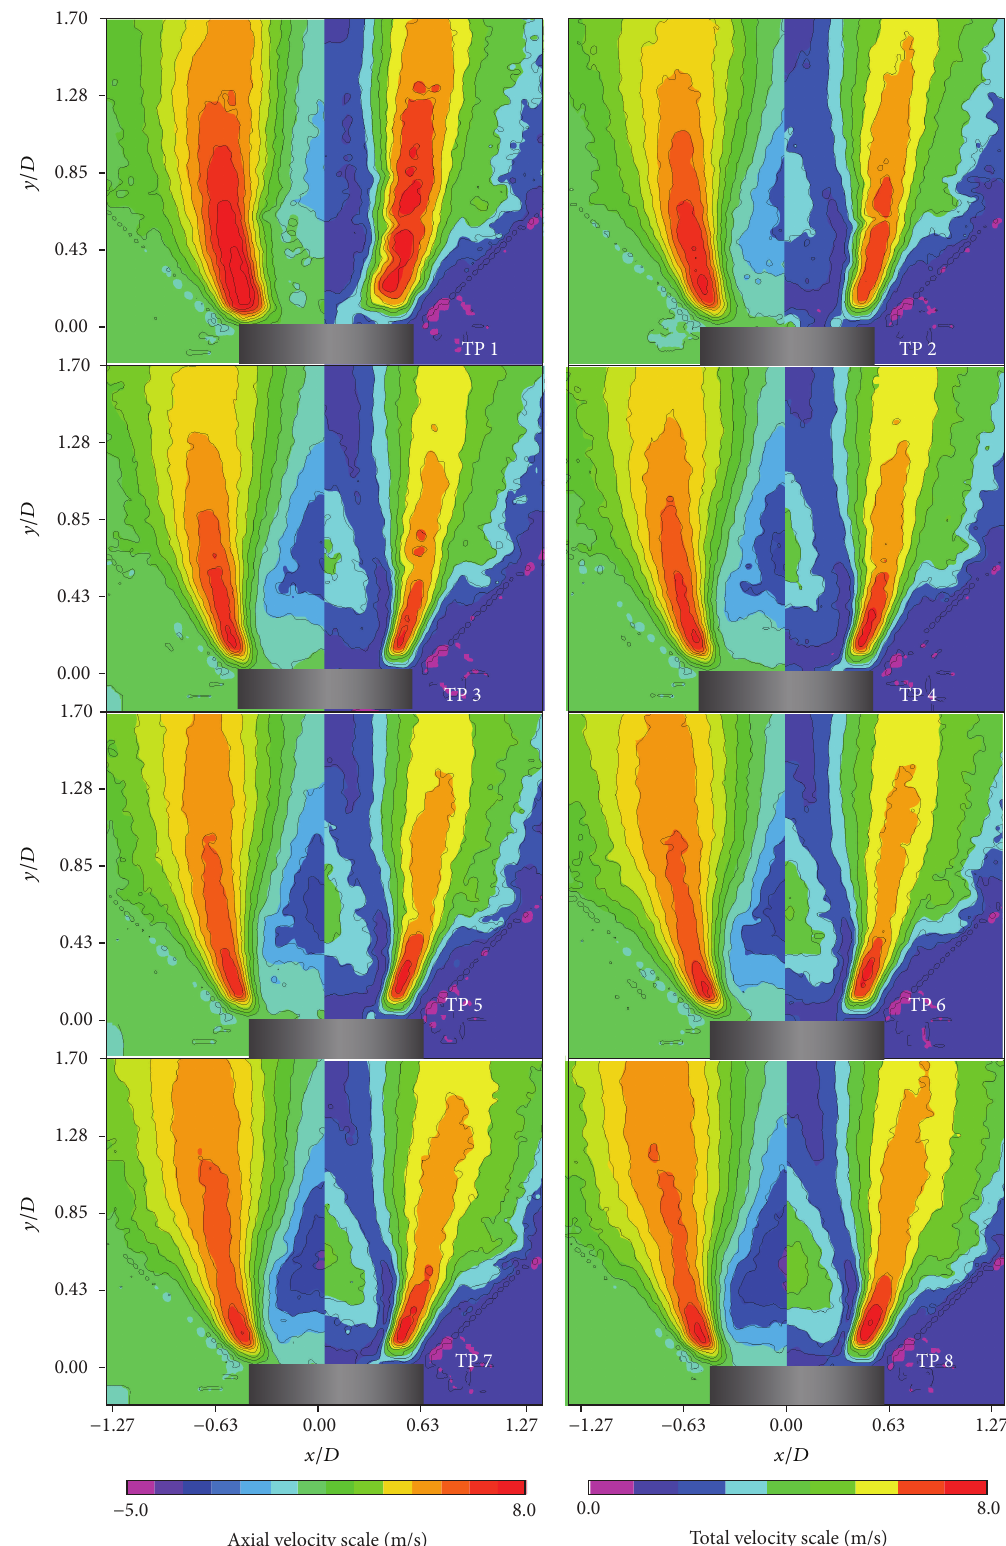
Figure 3: Scalar plots of TP 1 to TP 8 in the AGSB as detailed in Table 1, the left half of each image indicates axial velocity, and the right half total